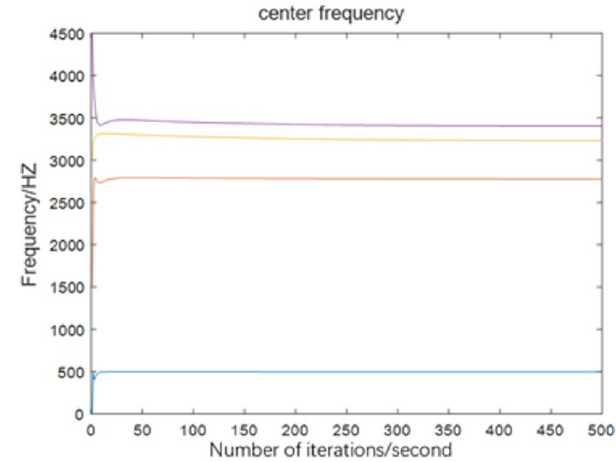
Figure 1. Center frequency of the modal component K = 4.